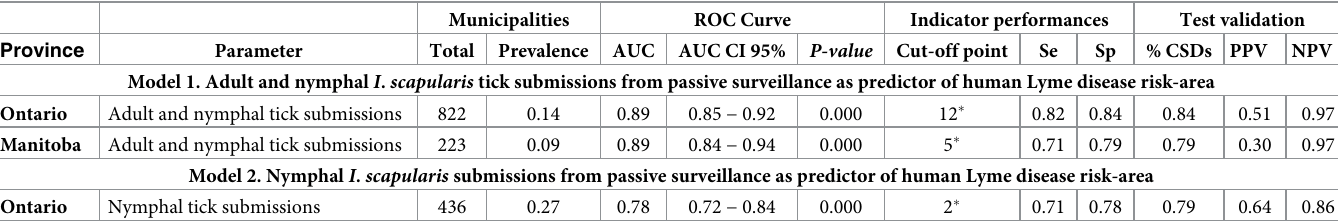
Table 3. The performances of the optimal risk indicators and their validation under the current epidemiologic Lyme disease